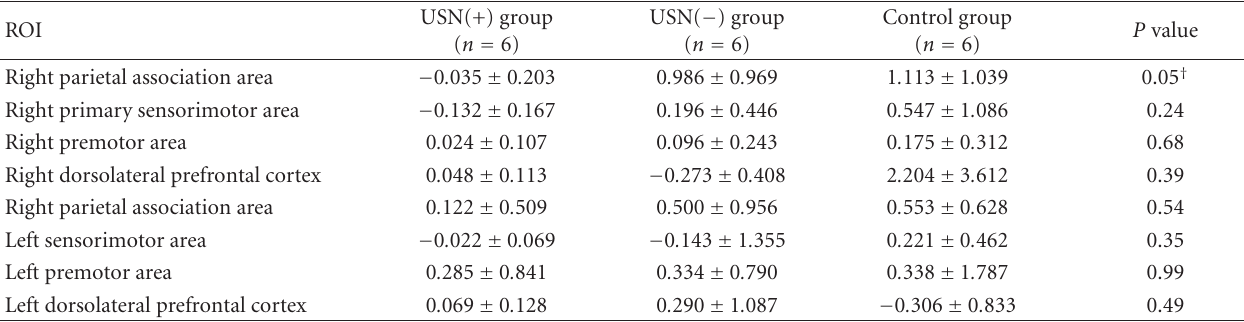
Table 2: Comparison of e ff ect size between regions of interest (ROIs) in 3 study groups.